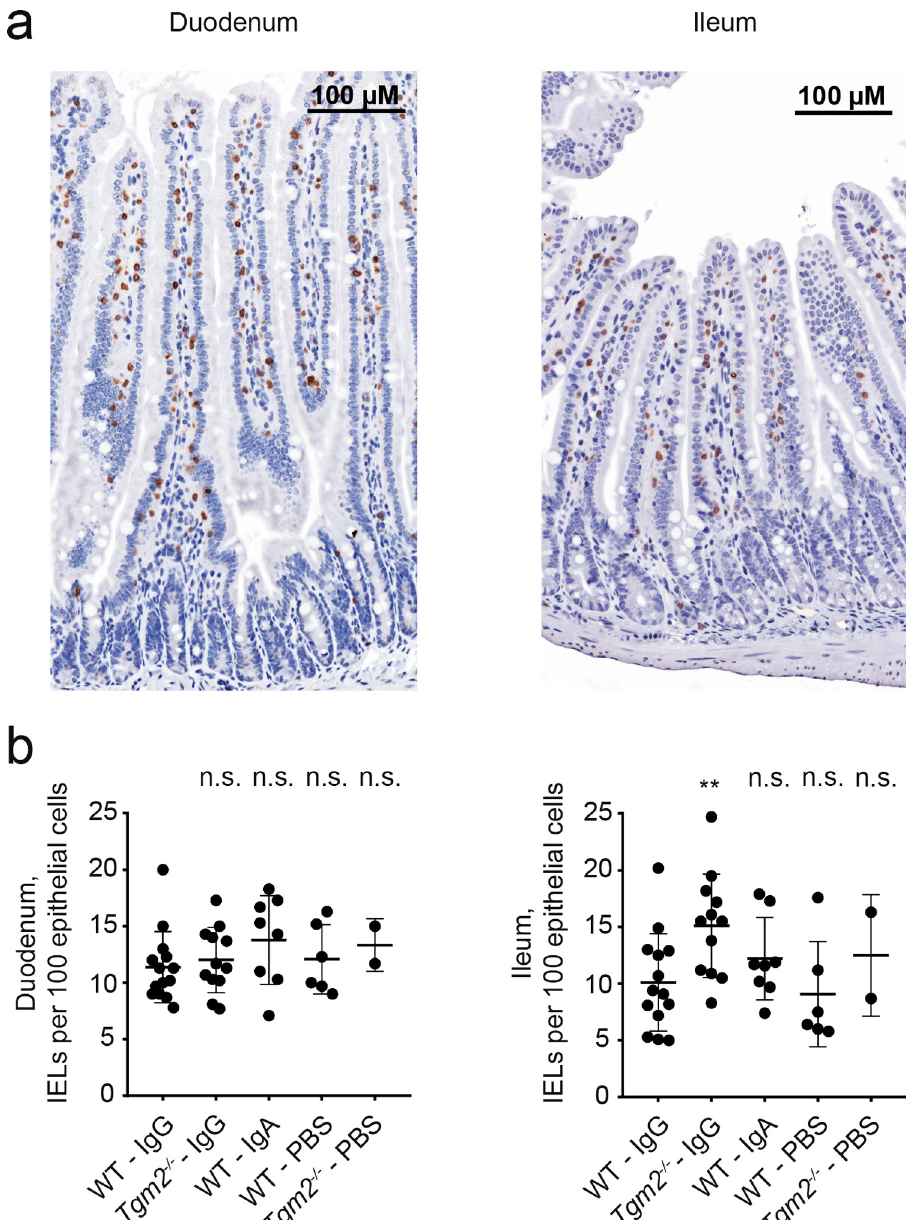
Fig 6. IEL count in duodenum and ileum. (a) Examples of staining for anti-CD3. Formalin-fixed paraffin-embedded sections stained with anti-CD3 and counterstained with hematoxylin. Representative images show CD3 + cells in duodenum and ileum. (b) CD3 + IELs per 100 epithelial cells in well-oriented villi in duodenum and ileum. The WT IgG group was compared to each control group by individual Mann-Whitney tests. Data represent all mice from the two independent experiments. Bars represent mean +/- SD. �� P � 0.01. n.s.: Not